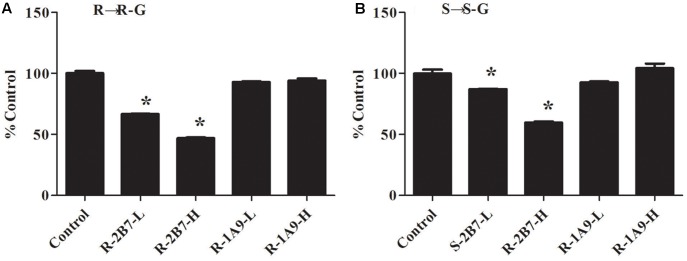
Inhibitory effect of specific inhibitor on the formation of R(+)-NAF-G (A) and S(–)-NAF-G (B) in human liver microsomes. Control represent R(+)-NAF-G and S(–)-NAF-G were incubated without inhibitor. While UGT2B-L and UGT2B-H groups represent NAF enantiomers incubated with fluconazole of 0.25 and 2.5 mM. UGT1A9-L and UGT1A9-H groups represent NAF enantiomers incubated with niflumic acid of 5 and 50 μM. The samples were processed and analyzed by LC-MS/MS as described in the Section “Quantification of R(+)-NAF-G and S(–)-NAF-G.” Each column represents mean ± standard error of triplicate samples. The asterisk “∗” indicates a statistically significant different (p < 0.05) to the control group, according to Student’s t-test.